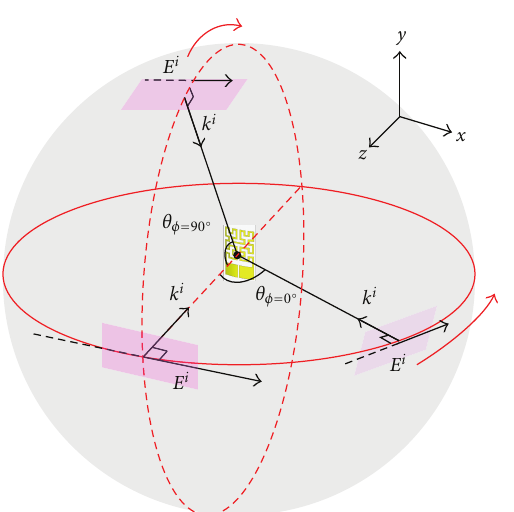
Figure 11: Simulation setup of the incident plane wave to obtain the antenna factor K .